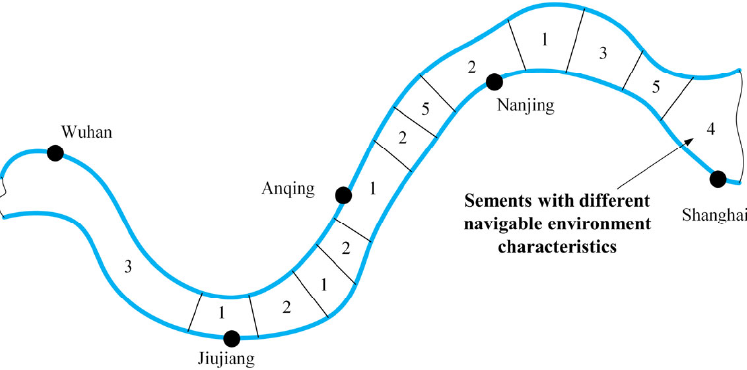
Figure 6. Clustering results of the navigation environment.